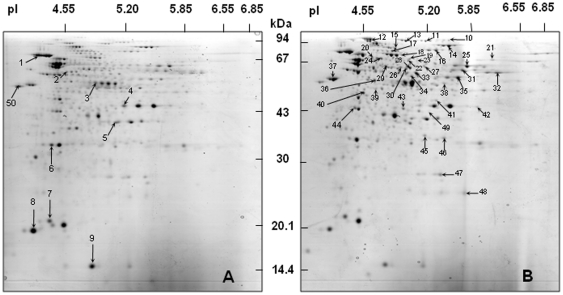
Two-dimensional analysis of proteins produced during P. freudenreichii CIRM-BIA1T growth (A) at 30°C (reference time 20 h) and then (B) at 4°C (3 days). Numbers identify spots which volume decreased at 4°C (A), or increased at 4°C (B). The identification by MS/MS of each spot can be found in Table S4.